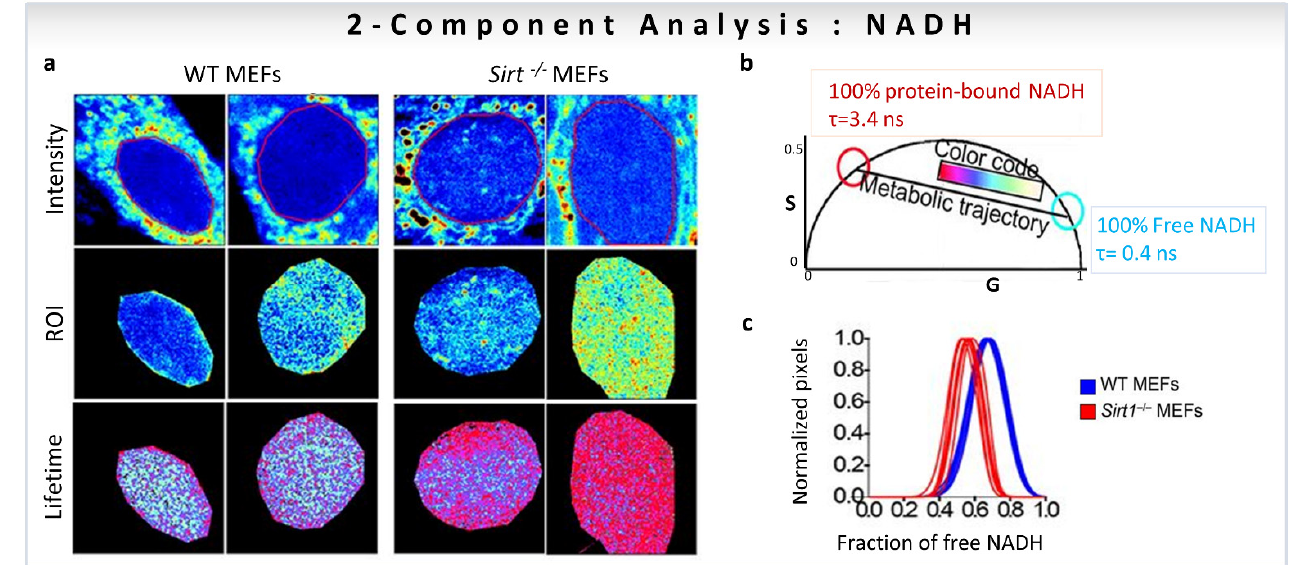
Figure 7. Biological examples of fractional intensity contributions of two species based on linear combination of phasor-FLIM. Two-component analysis (known lifetimes of the components) using a graphical approach for metabolic imaging using free to bound NADH. ( a – c ) Nuclear NADH metabolism is dependent on the activity of Sirt1. ( a ) Intensity and lifetime (FLIM) images for WT and Sirt − / − MEFs. Two representative images per condition are shown. ( b ) Phasor plot shows the color scale used to visualize the fraction of free/bound NADH along the metabolic trajectory in FLIM images. ( c ) Histograms show comparative analyses by overlapping the fractional free NADH distributions from WT (cyan) and Sirt − / − (red) MEFs. Free NADH fraction is represented in the x axis, where 1 = 100% free NADH. (Panels adapted with permission from [17]).